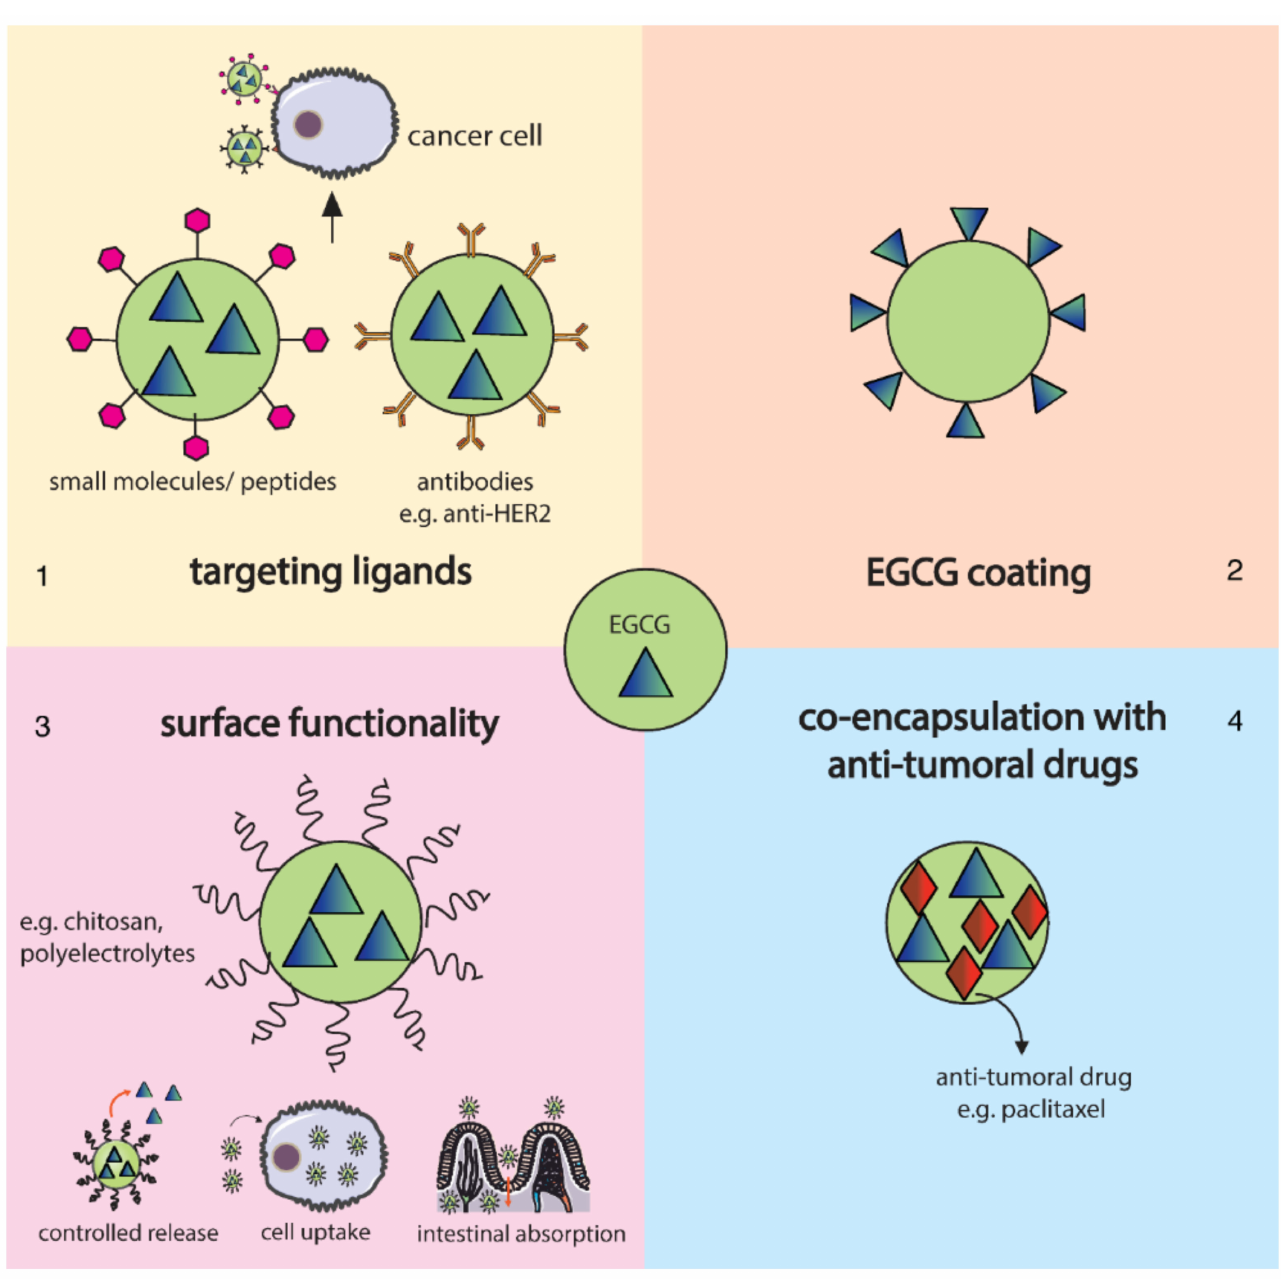
Figure 5. EGCG delivery possibilities for cancer therapy: ( 1 ) incorporation of ligands on NPs surface for specific targeting of cancer cell receptors or antigens; ( 2 ) EGCG used as a capping agent; ( 3 ) surface functionalization with polymers for improving drug release, cellular uptake, and intestinal absorption; ( 4 ) co-encapsulation with conventional chemotherapeutic agents. Reprinted from an open-access source